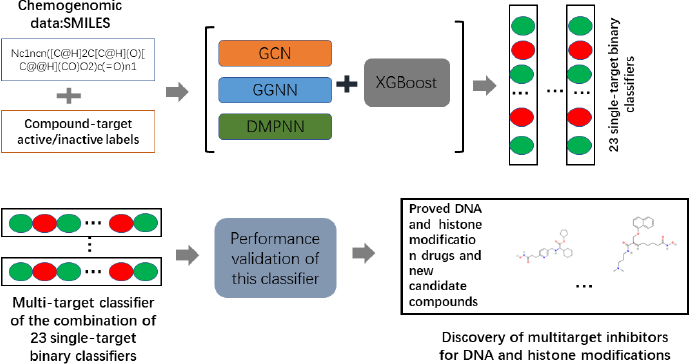
Figure 1. Workflow of our study.